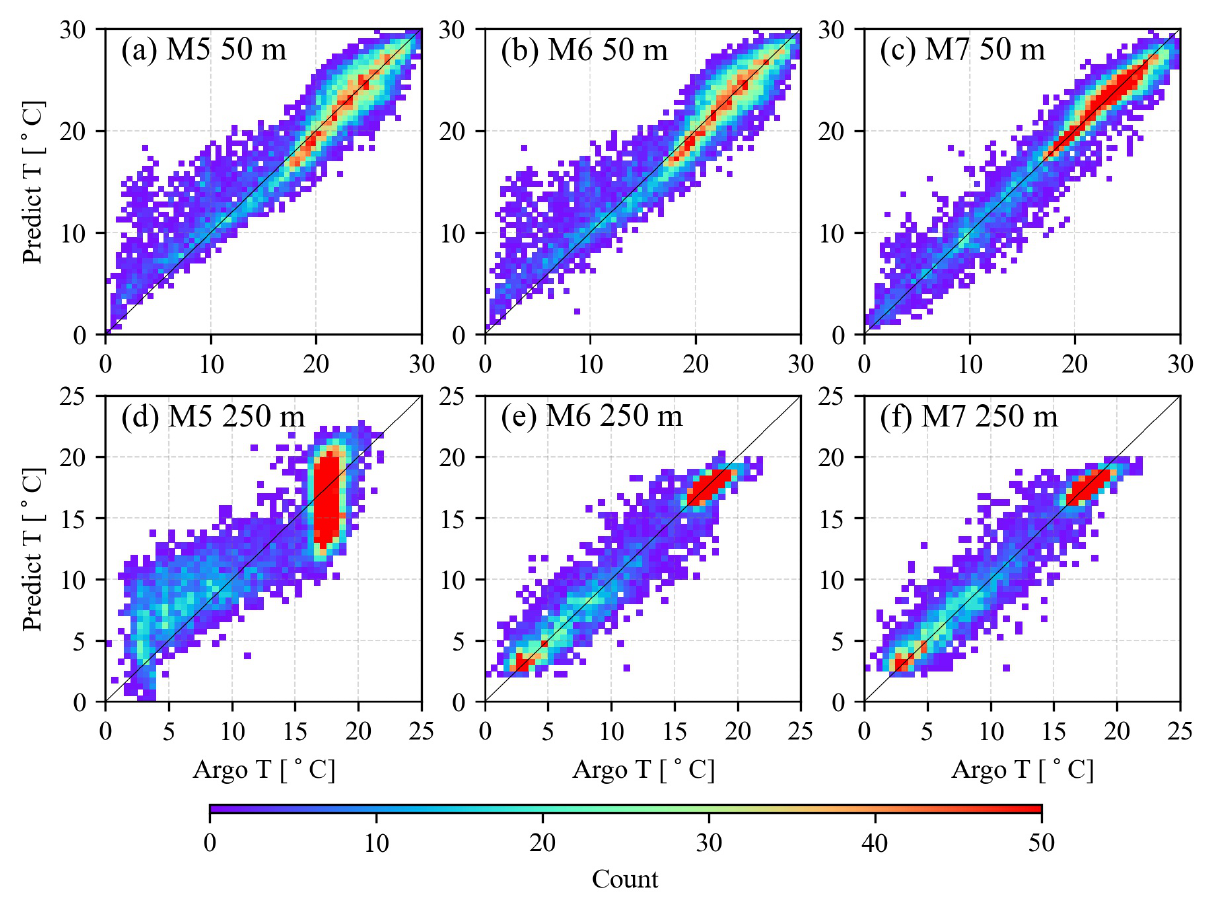
Figure 6. Q-Q plot of reconstructed temperature relative to Argo-measured temperature at two depths of (top) 50 m and (bottom) 250 m for ( a , d ) model 5, ( b , e ) model 6 and ( c , f ) model 7, respectively. Color represents the data density at a temperature bin of 0.5 ◦ C for both the x- and the y-axis. Furthermore, the overall mean values of ∆ T , RMSE and MAE at depths of 50 m and 250 m calculated between the Argo-measured and model-predicted temperatures for